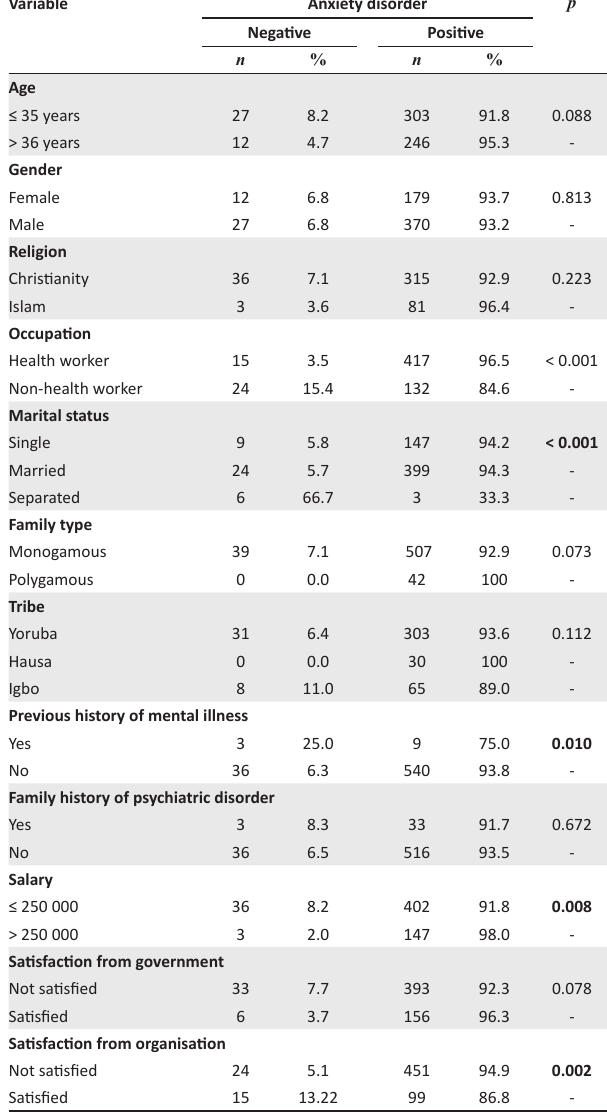
TABLE 3: Association of socio-demographic characteristics of the respondents with